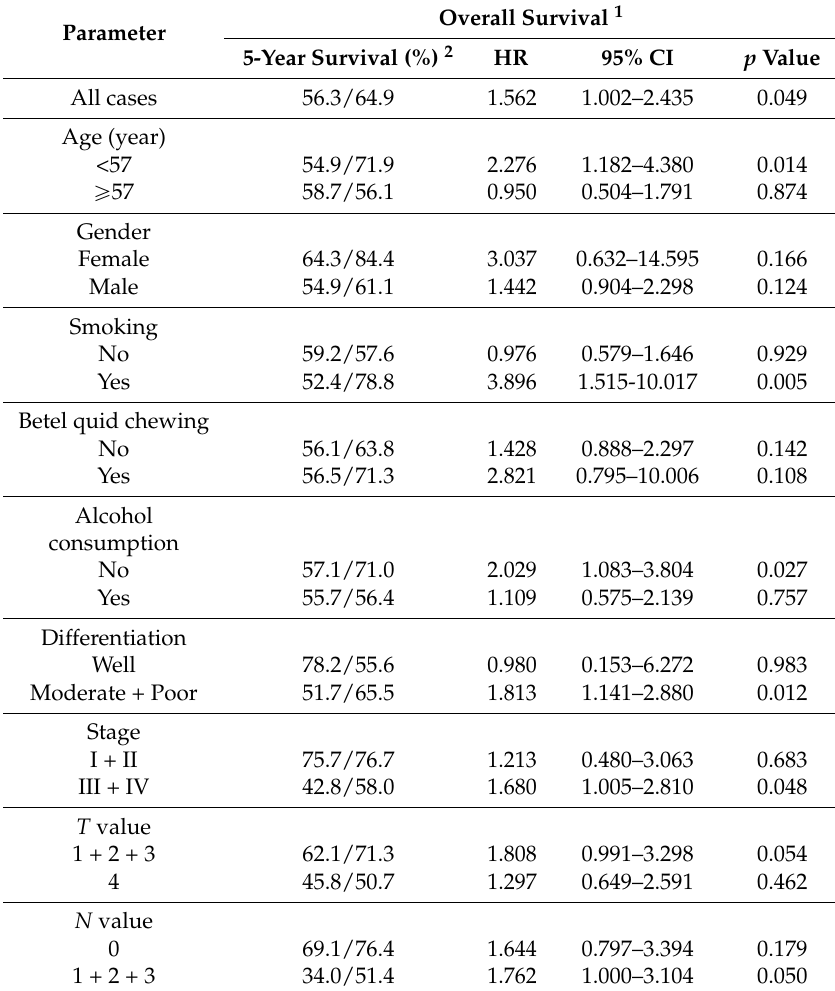
Table 4. Multivariate analysis of the PBK/TOPK expression according to clinical parameters in overall survival of patients with oral